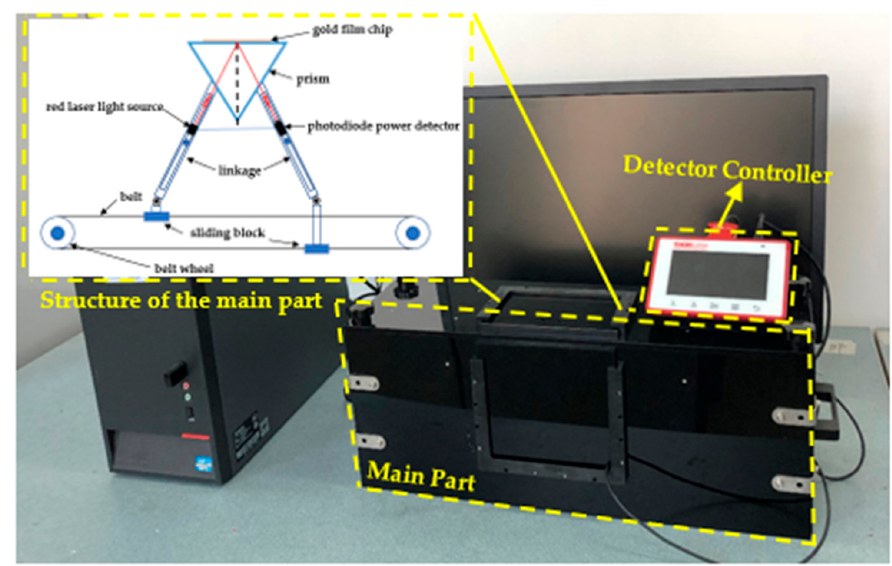
Figure 2. Real surface plasmon resonance (SPR) instrument set-up in this paper.